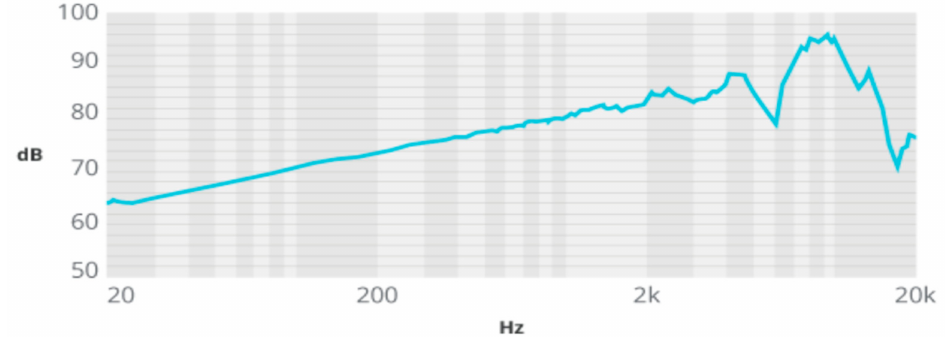
Figure 4. Typical piezoelectric sensor sensitivity in sound pressure